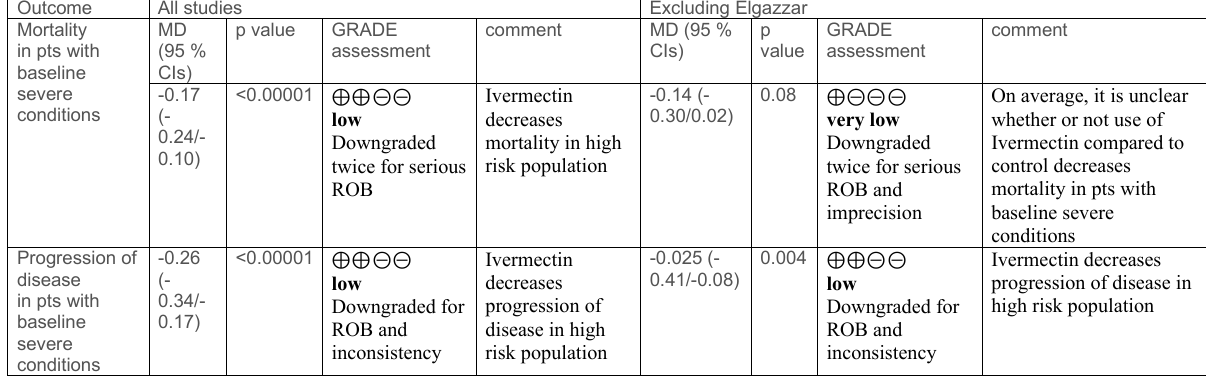
Table 1. Sensitivity analysis of some outcomes of the meta ‐ analysis.